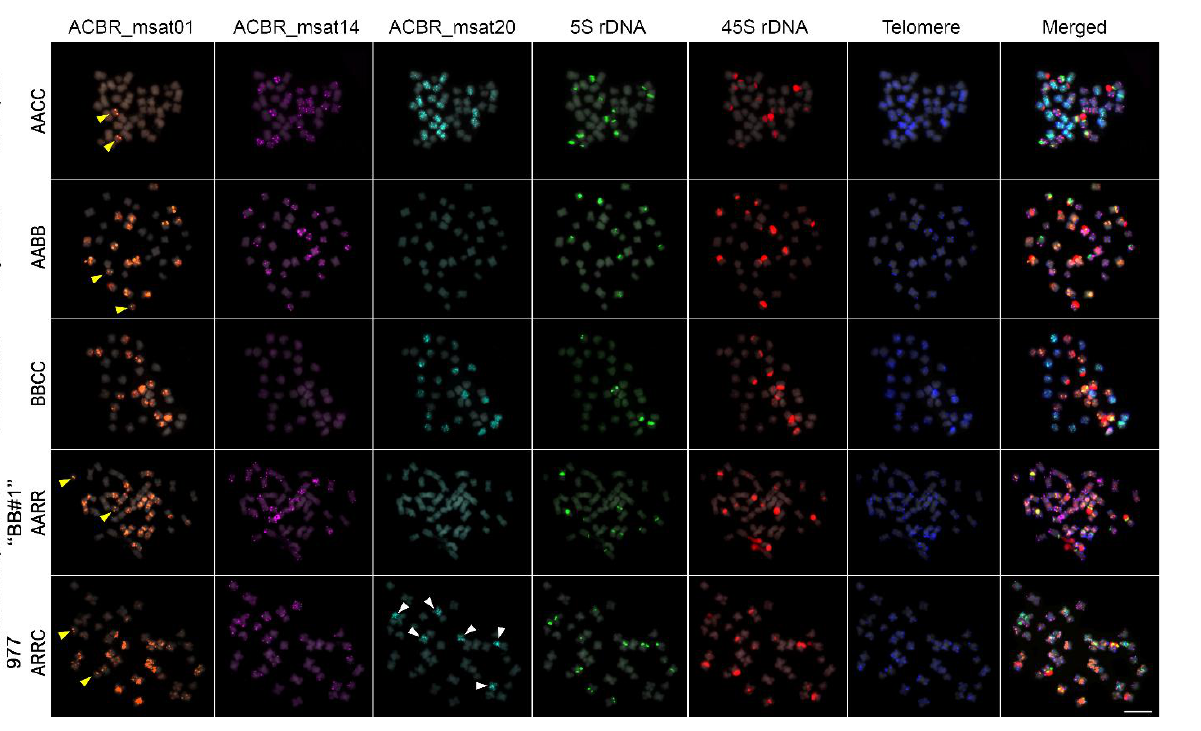
Figure 4. FISH analysis of ACBR_msat01, ACBR_msat14, and ACBR_msat20 in B. napus , B. juncea , B. carinata , × Brassicoraphanus ‘BB#1′, and × Brassicoraphanus 977. ACBR_msat14, and ACBR_msat20 clearly discriminated the A and C genomes in the allopolyploids, respectively. ACBR_msat01 was useful in discriminating the B-genome in the interspecific AABB and BBCC allopolyploids, the R genome in the intergeneric AARR genome, and chromosome A8 (yellow arrowheads). Note the six chromosomes with ACBR_msat20 in × Brassicoraphanus 977 indicating C-genome chromosome blocks (white arrowheads). Scale bar = 10 µ